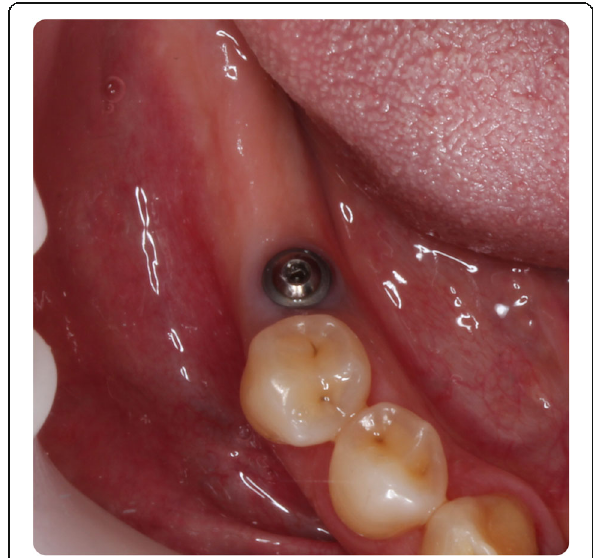
Fig. 10 Most recent fixture photograph. Fixture in 46 position visible through the mucosa due to superficial positioning